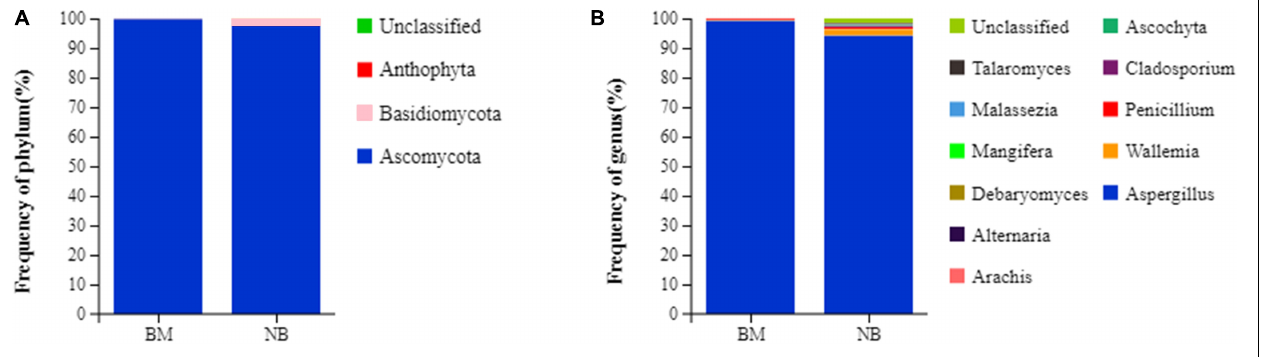
Frontiers in Microbiology |